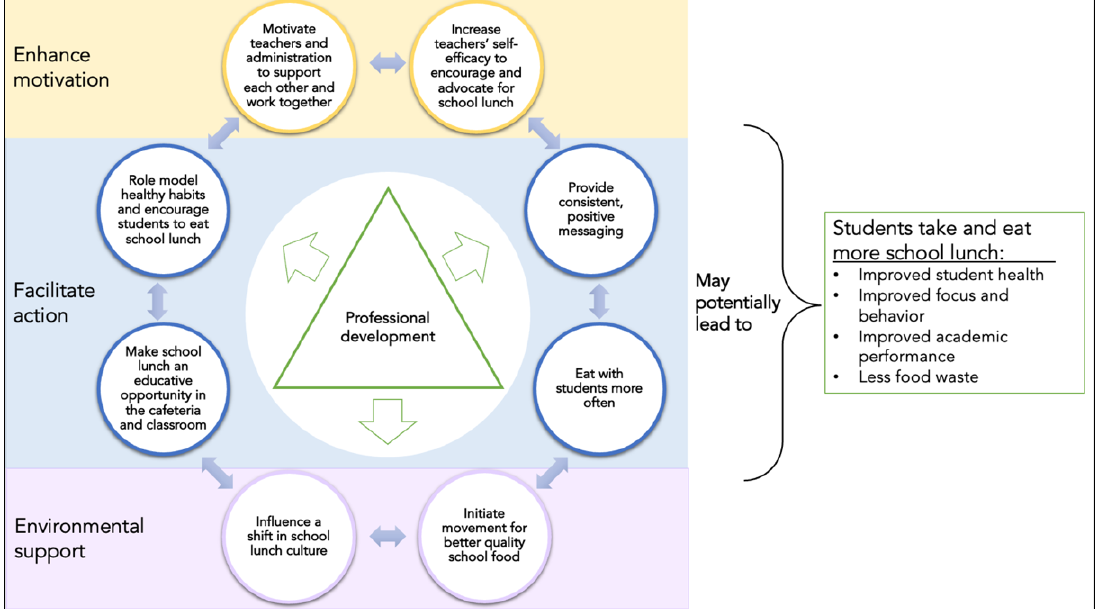
Figure 2. Framework for School Lunch Professional Development based on K-12 teachers’ recom- mendations and suggestions to play a greater role in school lunch. K-12, kindergarten through twelfth grade.